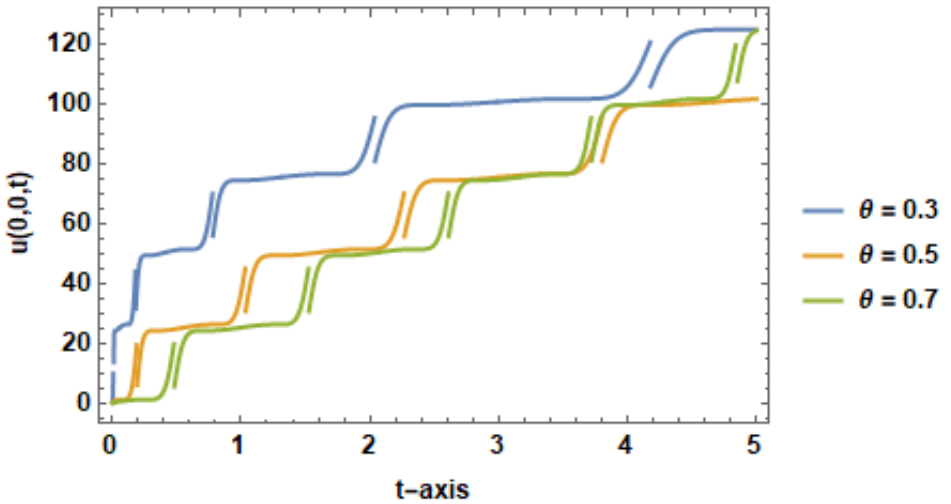
= 2, and (cid:2016) = 0.5 . 1